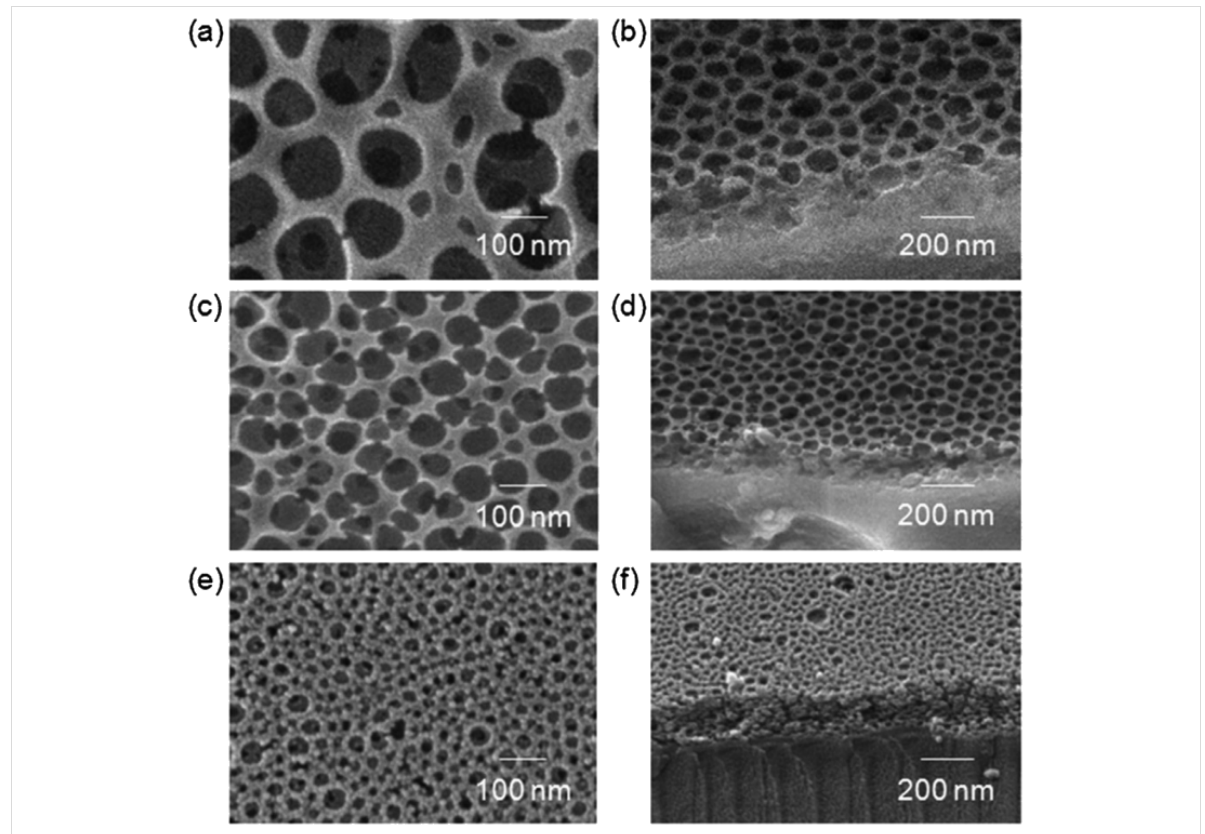
Figure 6: Top-view (left) and tilted 60° (right) SEM micrographs of PS 962 - b -PEO 3409 (a, b), PS 563 - b -PEO 1614 (c, d) and PS 385 - b -PEO 1205 (e, f) soft-templated titania films. Reproduced with permission from [105], copyright 2011 The Royal Society of Chemistry.